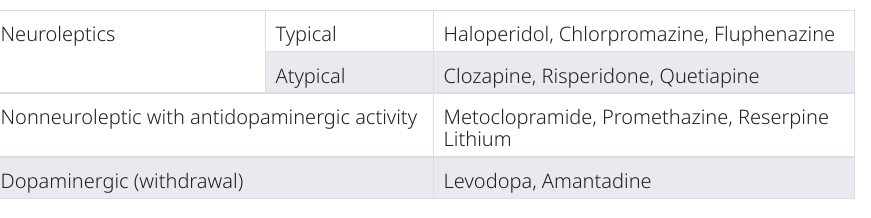
Table 1. Causative medications for neuroleptic malignant syndrome.